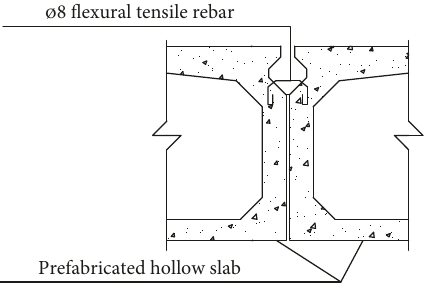
Figure 16: Tensile rebar of the hinge